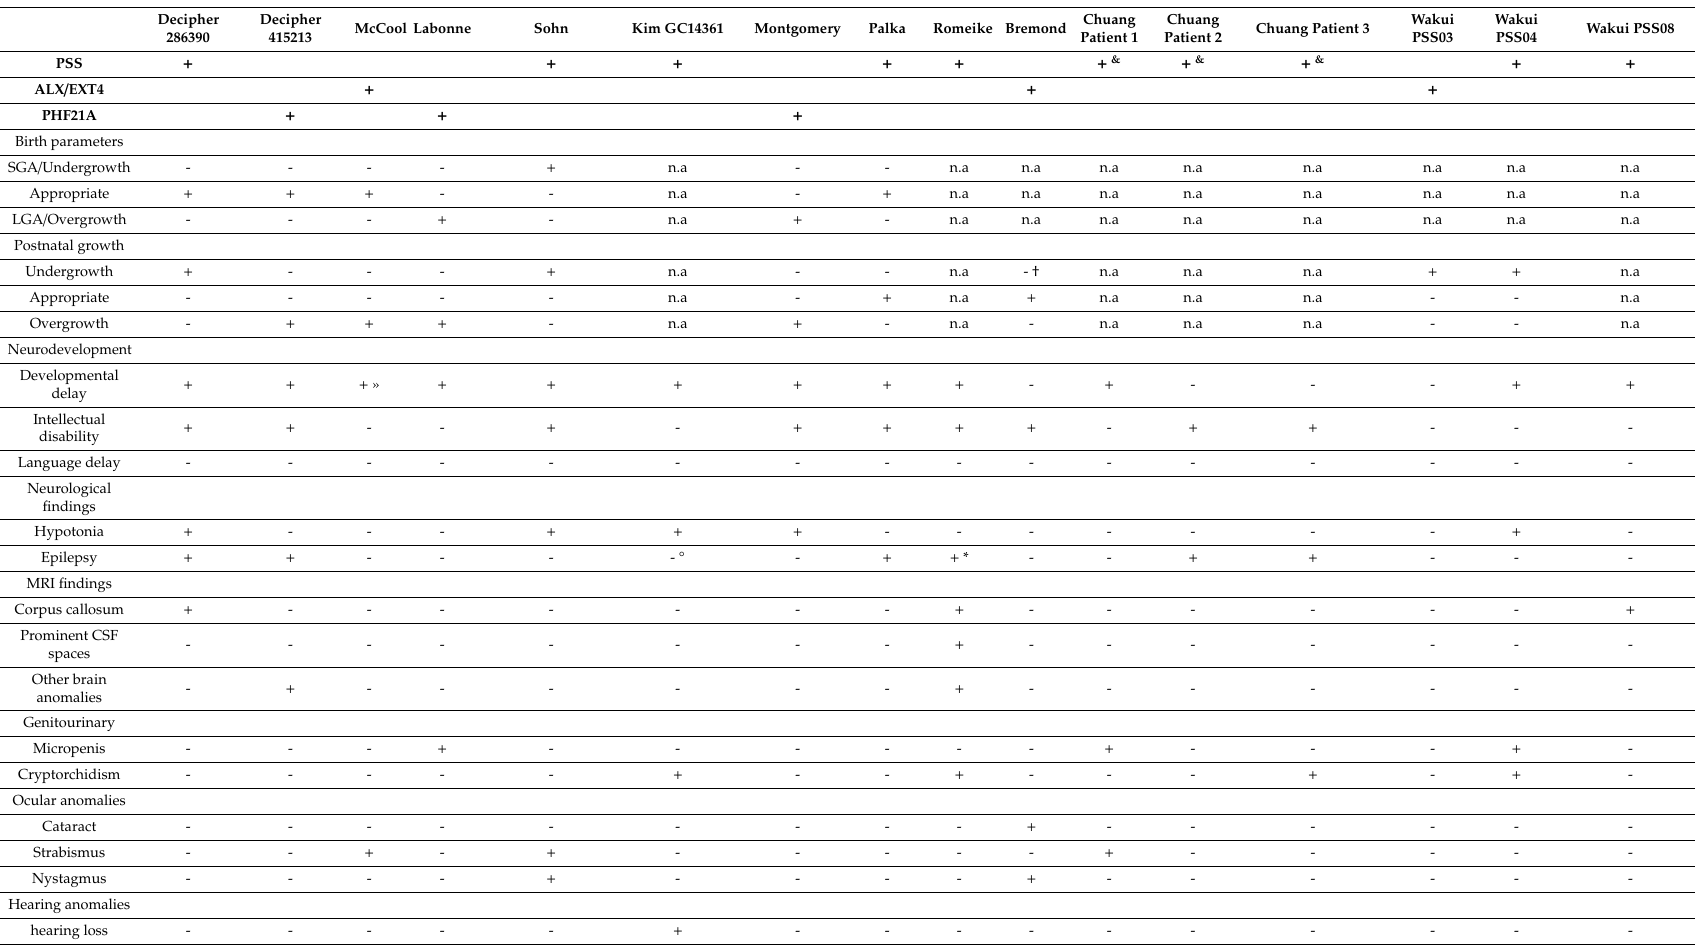
Table 1. Clinical characteristic of PSS cases reported in the